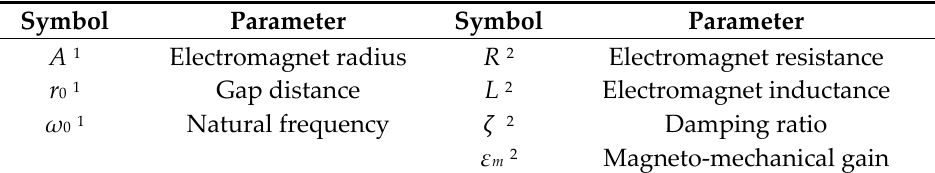
Table 1. Actuator-specific model